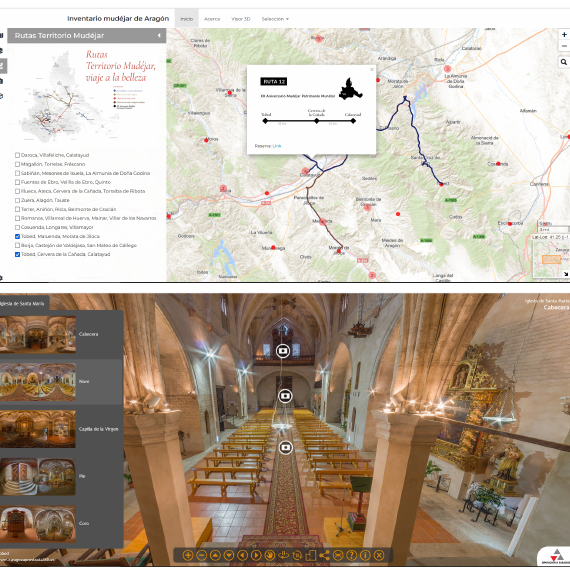
Figure 8. WebGIS viewer including (top) tourist Mud´ejar itineraries and (bottom) the 360 ◦ photography of the Santa Mar´ıa church (Tobed,